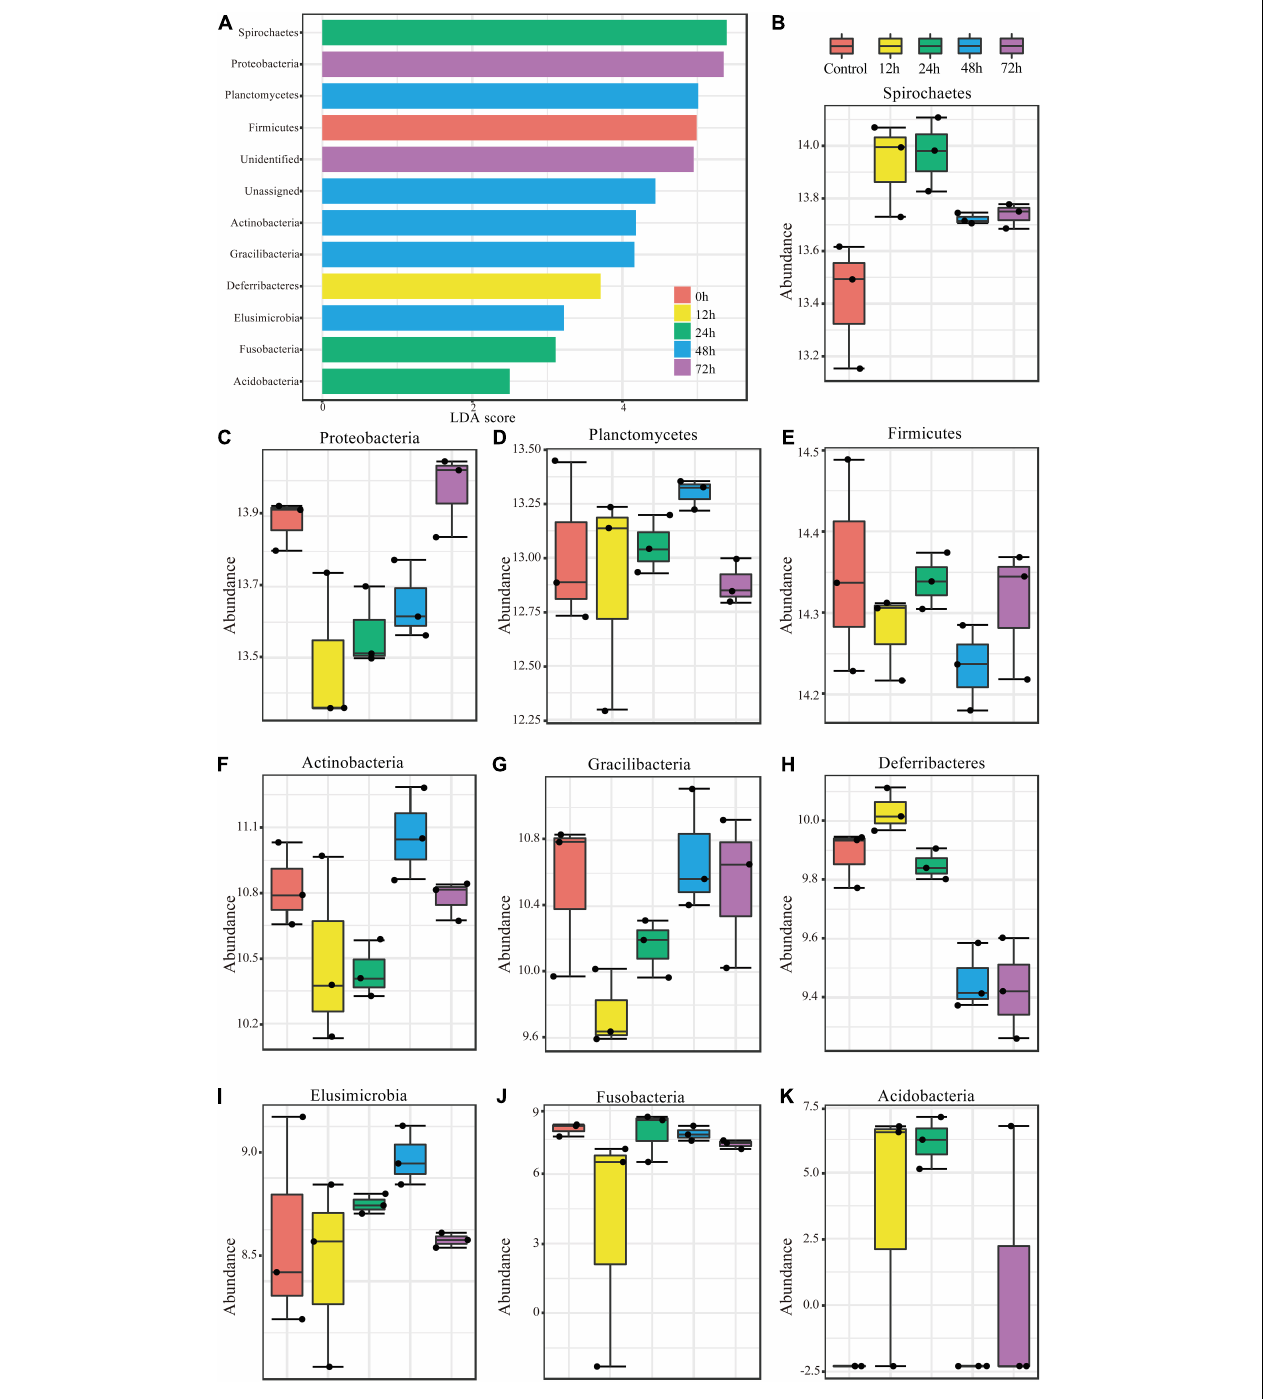
FIGURE 3 | Significant changes in phylum abundances and their specific trends over time. (A) Linear discriminant analysis (LDA) combined with effect size measurements (LEfSe) was used to screen qualified OTUs. They showed statistically different strains with LDA scores greater than a prespecified value of 2. Different colors refer to different time periods. (B–K) Relative abundances over time of the significantly different phyla.